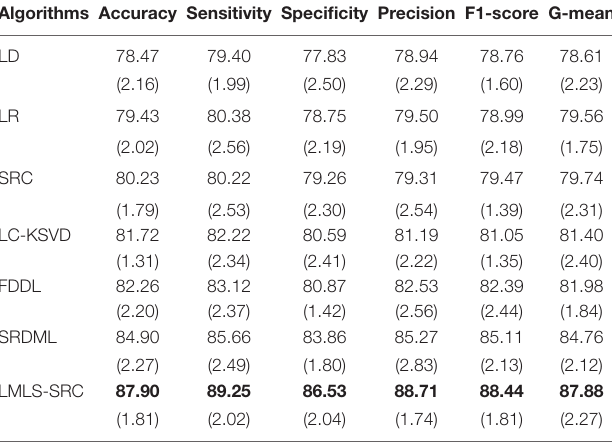
TABLE 4 | The comparative test results (with standard deviation) in three-class classification task.